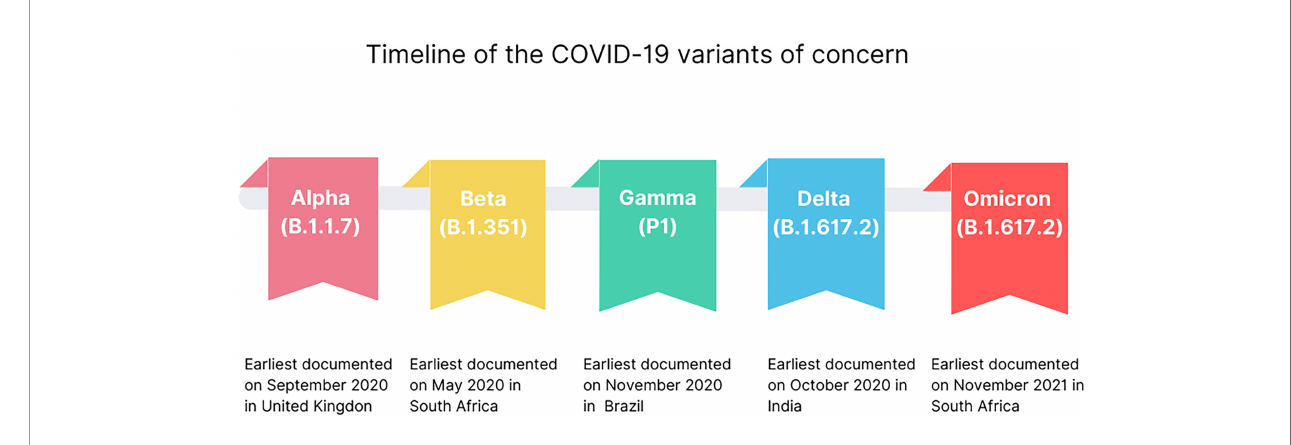
FIGURE 1 | Time line emergence of